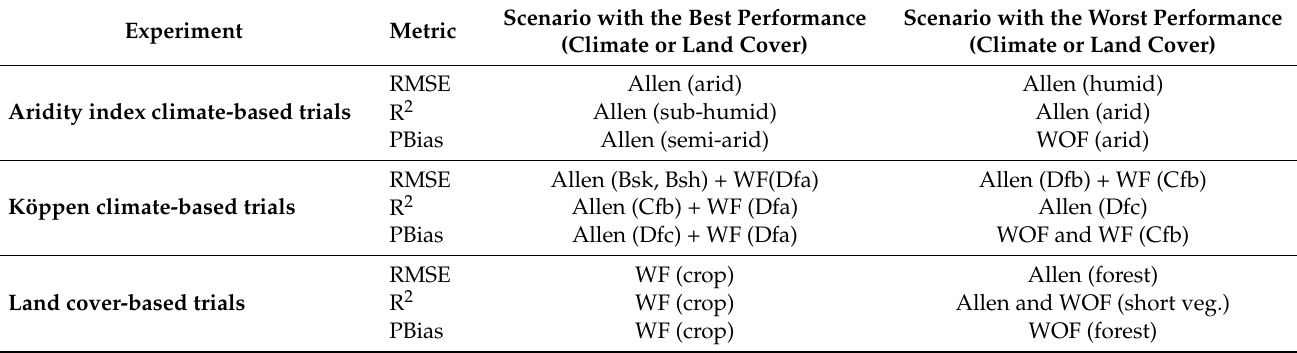
Table 4. Summary of ET estimation trials using the global aridity index, the Köppen climate classifi- cation and land cover type.